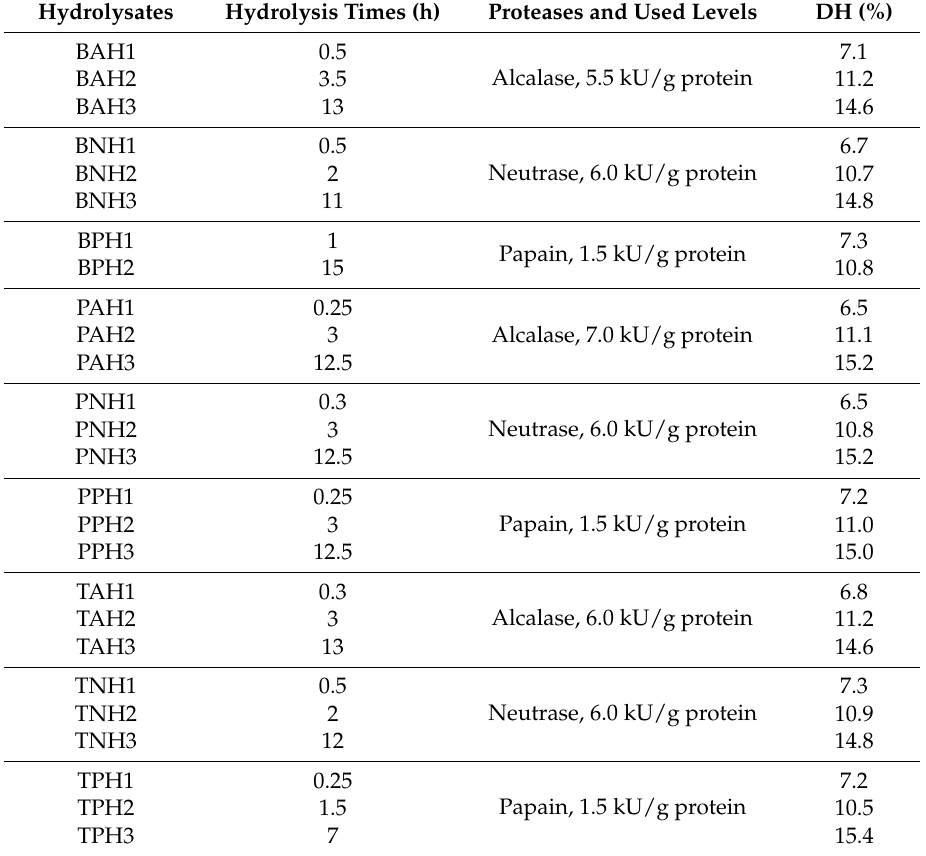
Table 1. Preparation conditions and measured degrees of hydrolysis